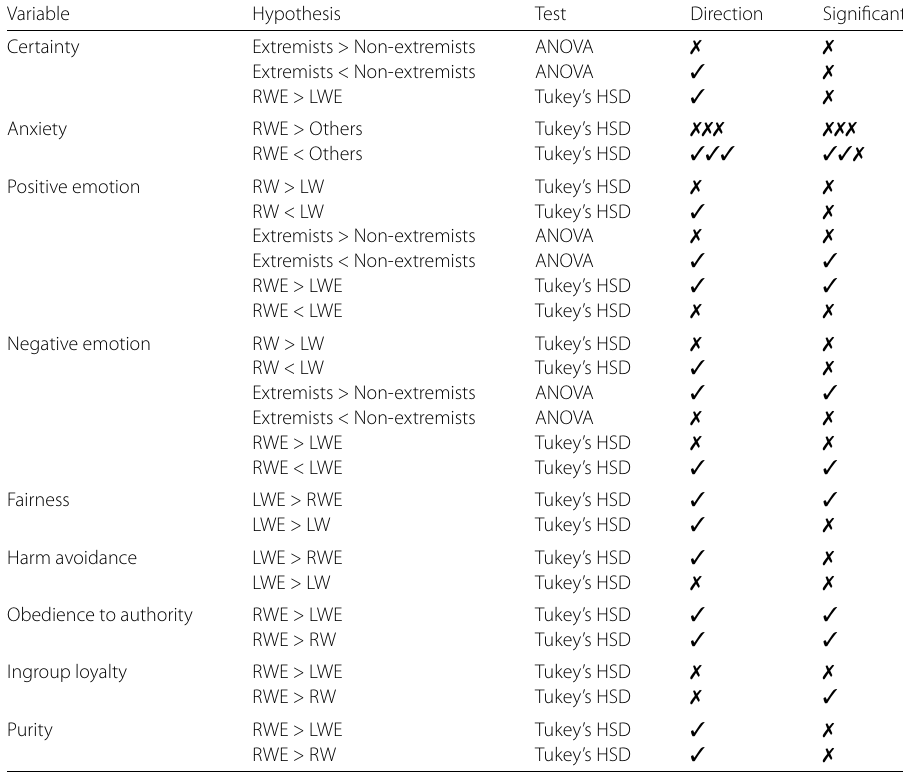
Table 22 Summary of hypotheses and results Variable Hypothesis Test Direction Significant Certainty Extremists > Non-extremists ANOVA